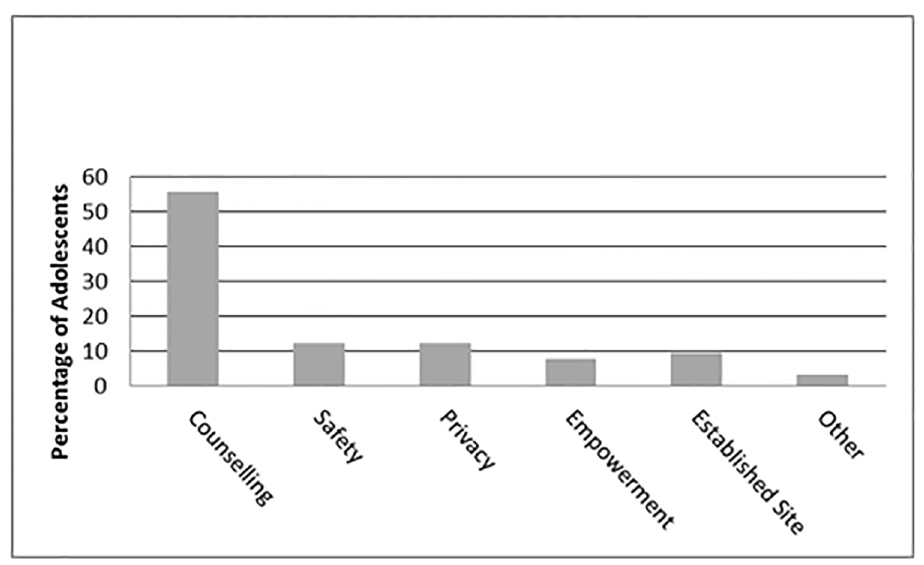
Fig 1. Determinants for choosing a testing